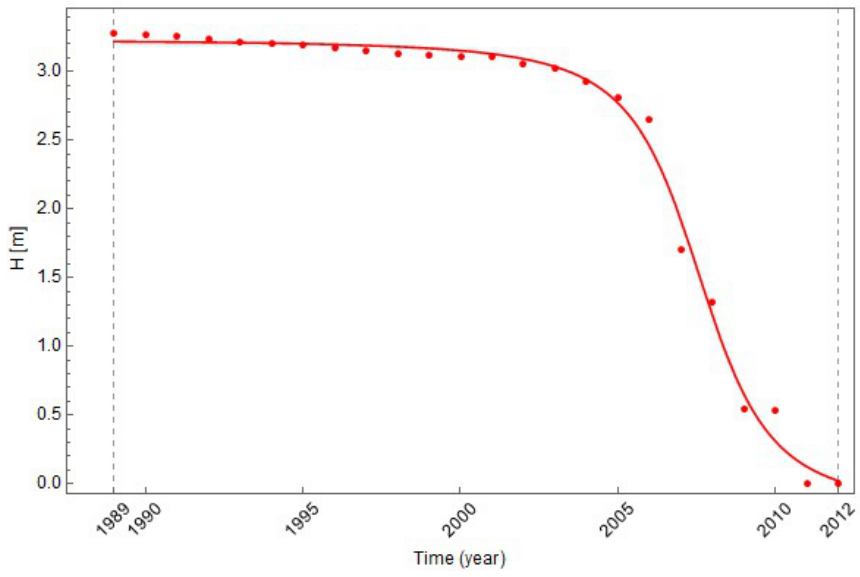
Figure 7. Graphical presentation of real measured data (red circles) and best fit theoretical modified sigmoid function (red curve) of point GB/6.